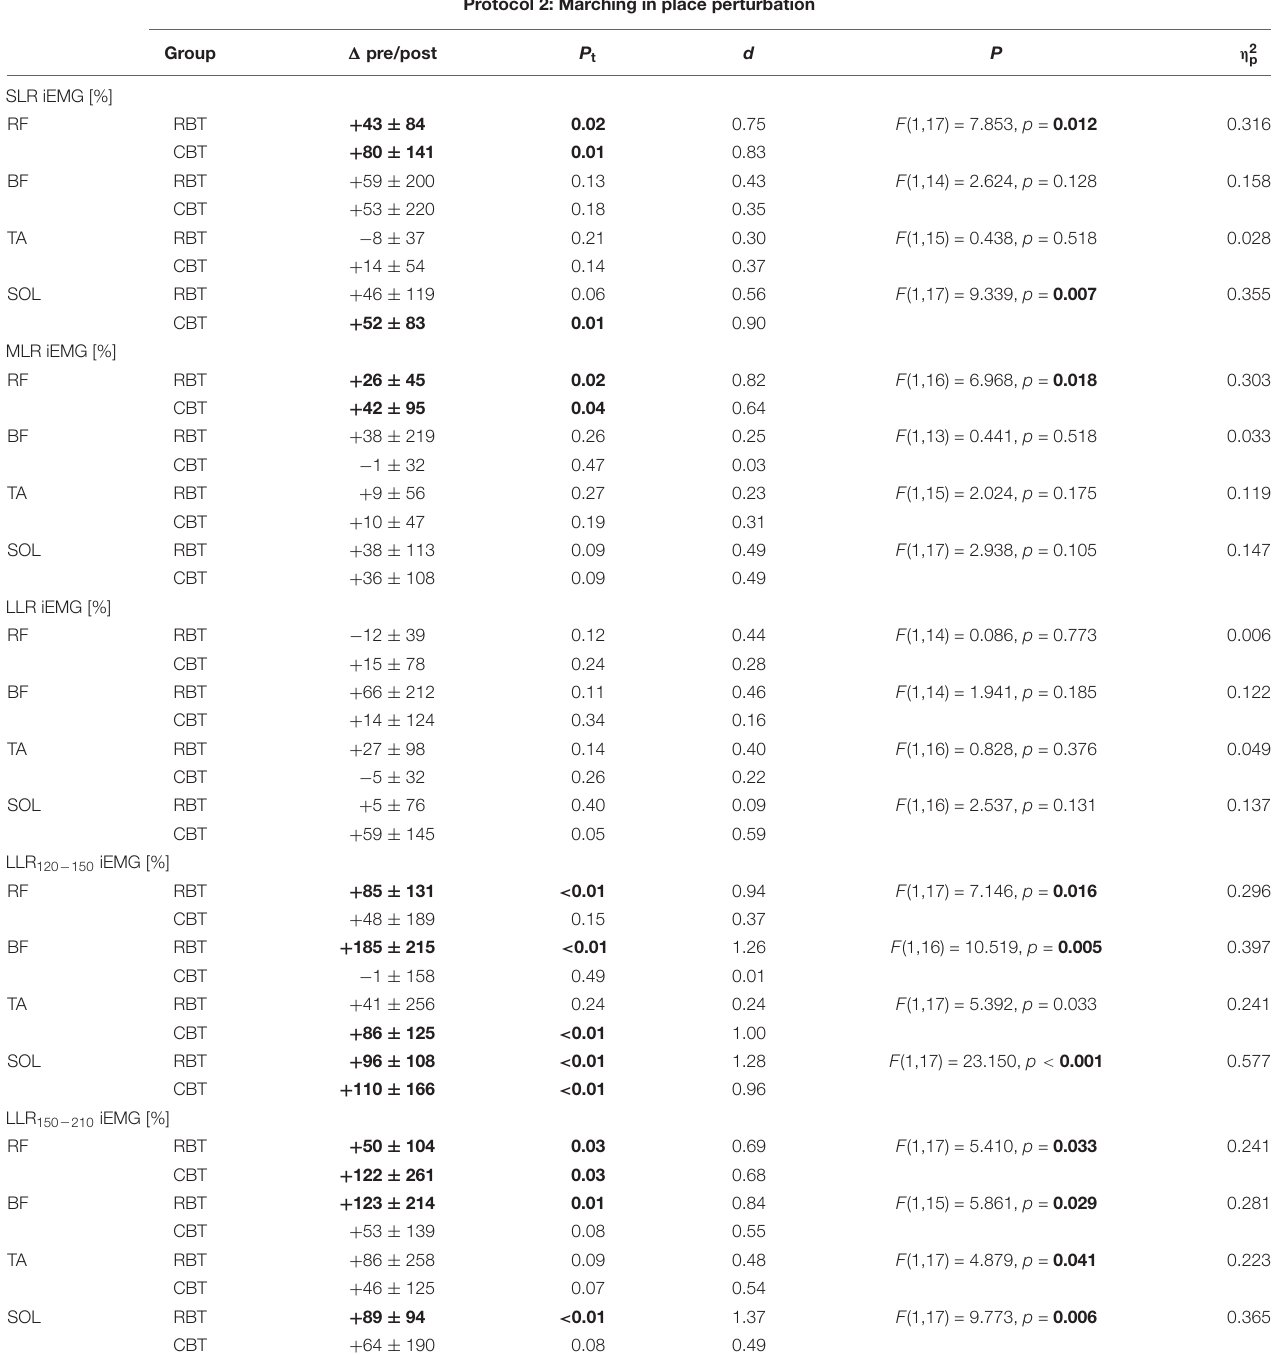
Protocol 2: Marching in place